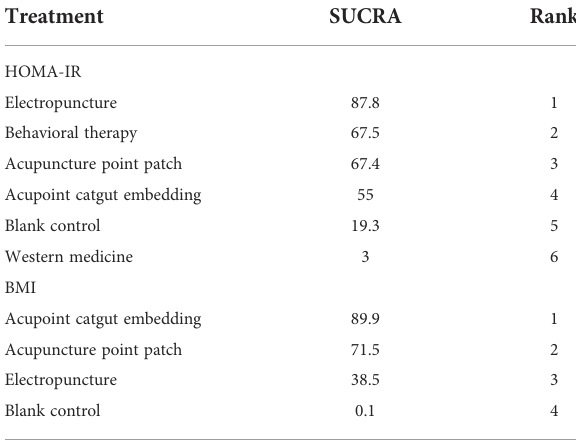
TABLE 4 Ef fi cacy ranking of mesh meta-analysis: homeostasis model assessment — insulin resistance (HOMA-IR) and body mass index (BMI).